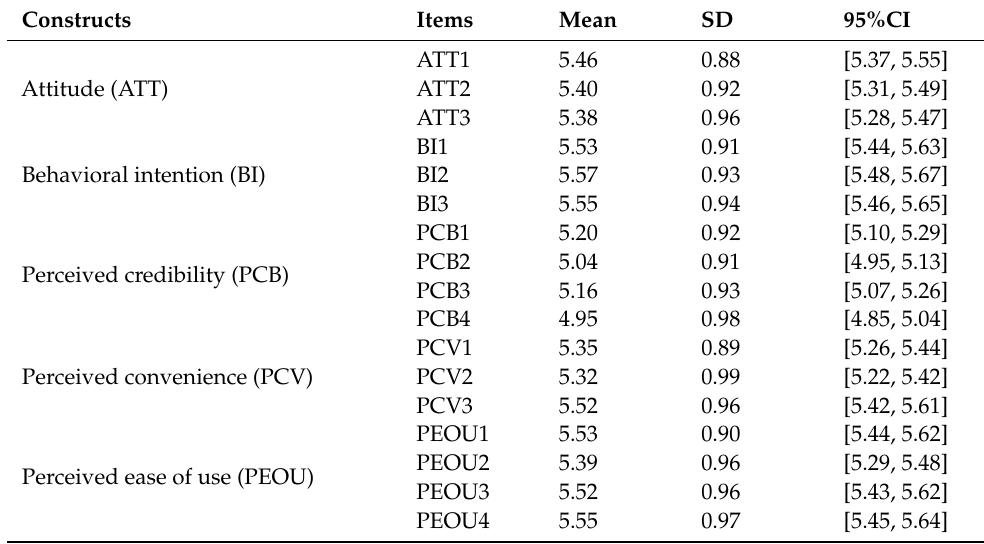
Table 3. Descriptive statistics of the measurement items for the